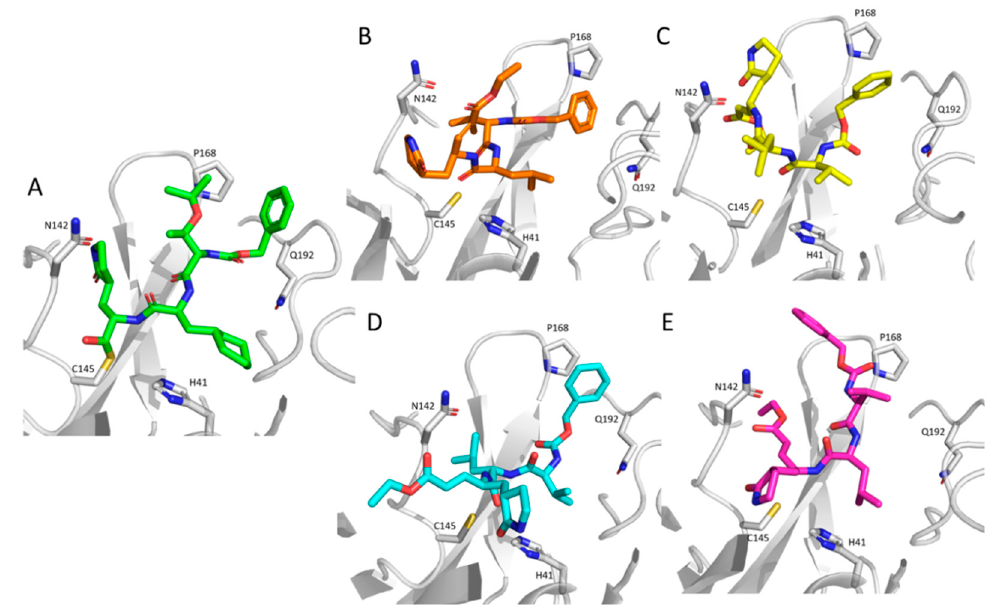
Figure 3. Comparison of the resolved complex of TG-0205221 with the SARS-CoV-2 3CL Pro enzyme ( A ) with the best poses as computed for its close analogue by PLANTS ( B ), LiGen ( C ), Fred ( D ), and Glide ( E ).